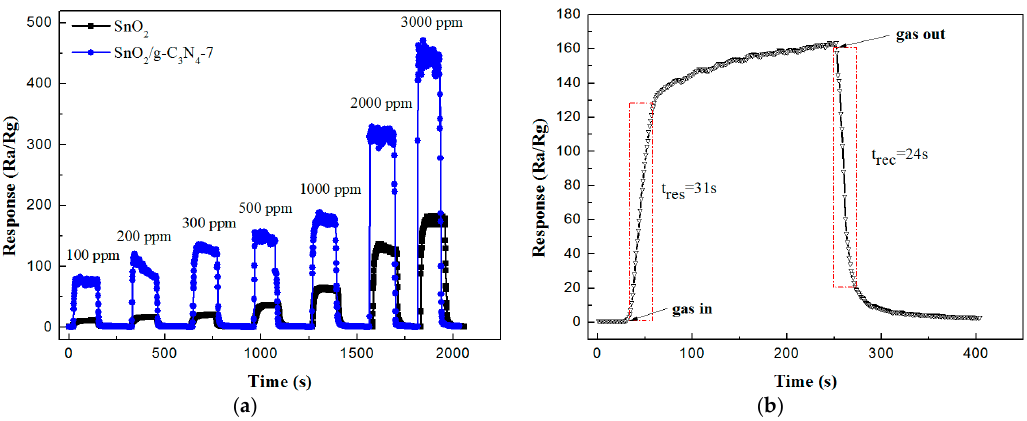
Figure 6. ( a ) The real time response curves of the SnO 2 and SnO 2 /g-C 3 N 4 -7 composite sensors toward ethanol vapor; ( b ) response-recovery time characteristics of the SnO 2 /g-C 3 N 4 -7 based sensor to 500 ppm ethanol vapor at 340 °C.